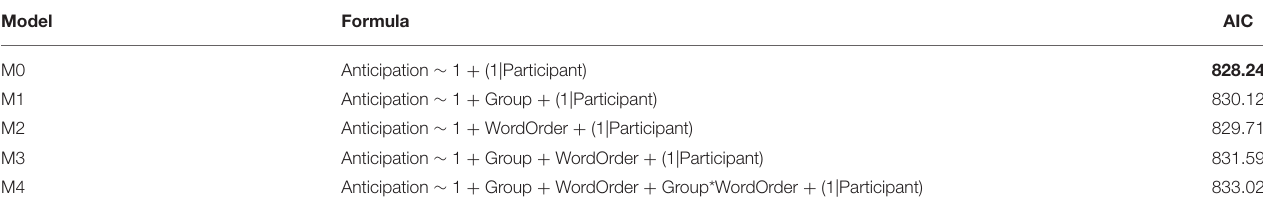
TABLE 7 | Model space for anticipations of the second object in the comprehension task.